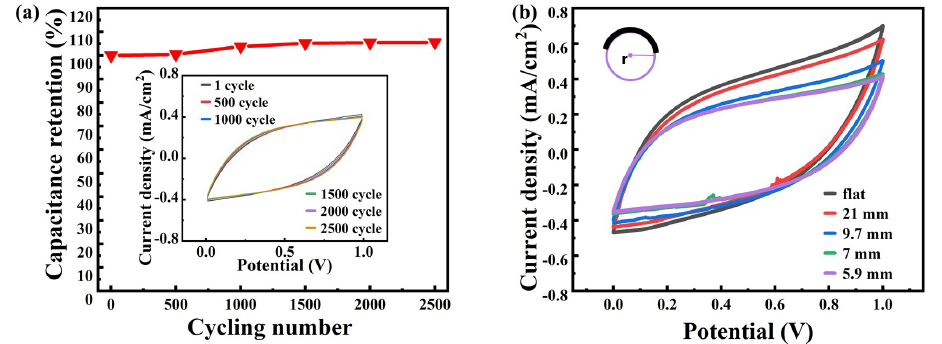
Figure 5. ( a ) Normalized capacitance plot with 2500 charge/discharge cycles (Embedded graph is the initial CV curve after 500, 1000, 1500, 2000, and 2500 cycles number of DLWT with the scan rate of 0.1 V/s.); ( b ) DLWT CV curves of various bending radius under 0.1 V/s scan rate.